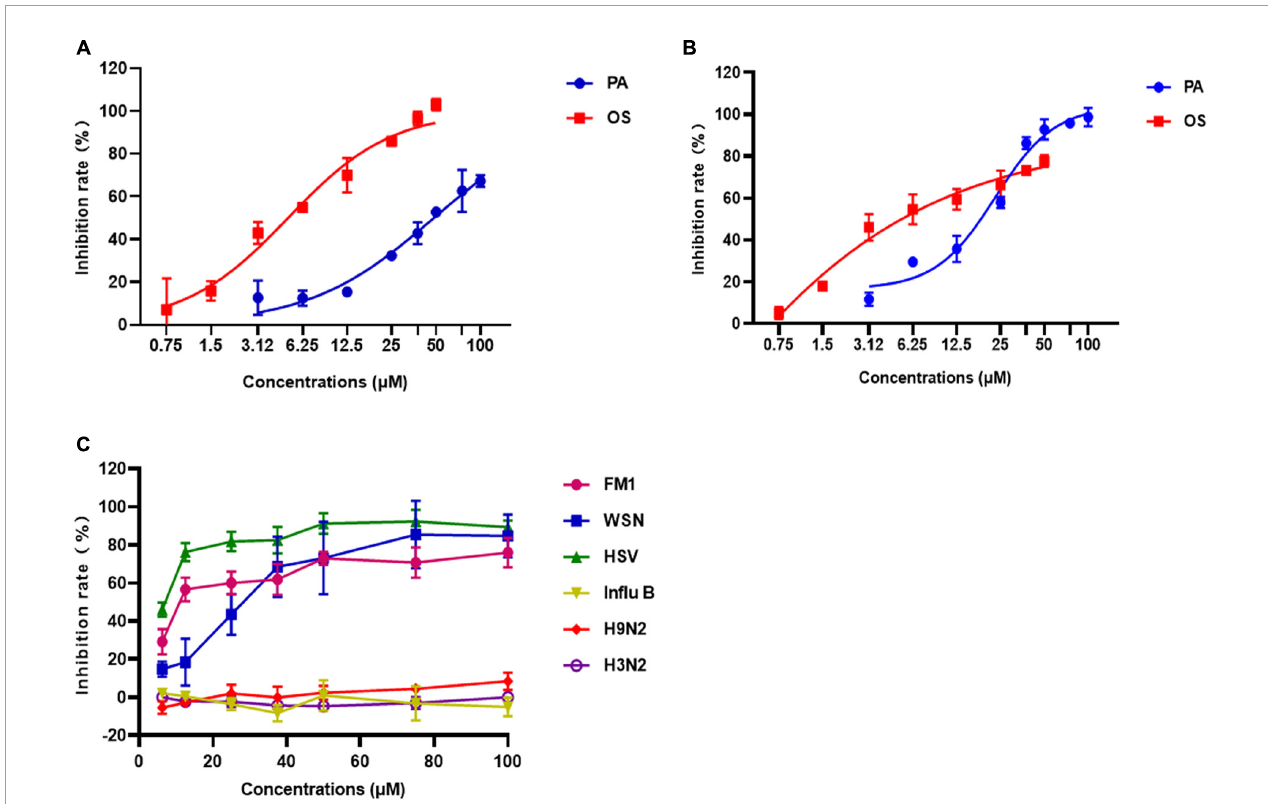
FIGURE3 The antiviral effects of Patchouli alcohol on A/Puerto Rico/8/34 (H1N1) strain and other strains of influenza viruses. (A) Inhibitory effects of various concentrations of Patchouli alcohol against A/Puerto Rico/8/34 (H1N1) strain influenza virus in Vero cells. Oseltamivir as a positive control. (B) Inhibitory effects of various concentrations of Patchouli alcohol against A/Puerto Rico/8/34 strain influenza virus in A549 cells. Oseltamivir as a positive control. (C) Inhibitory effects of various concentrations of Patchouli alcohol against A/FM/1/47 (H1N1), A/WSN/33 (H1N1, S31N, amantadine resistant), A/Chicken/Guangdong/1996 (H9N2), A/HongKong/498/97 (H3N2), and influenza B/Lee/1940 (IVB) in MDCK cells. n = 3, each concentration conducted in